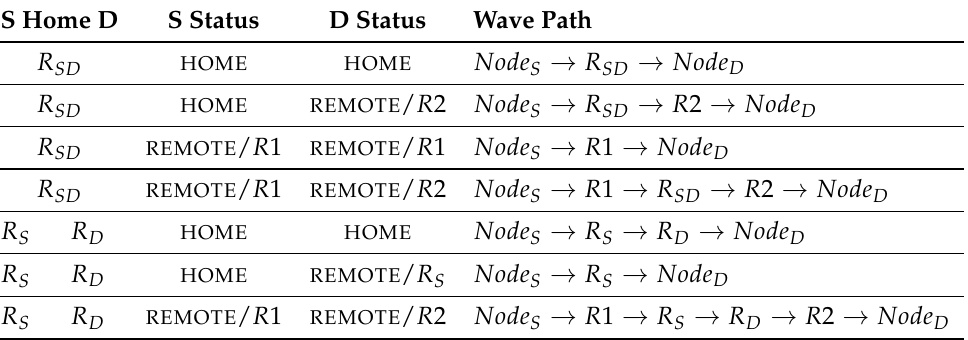
Table 1. The path taken by a wave from entity S to entity D , considering the same or different home regions, and various situations for their location. In every case, we call the actual nodes where the entities are located Node S and Node D , without meaning that those nodes are the same across different